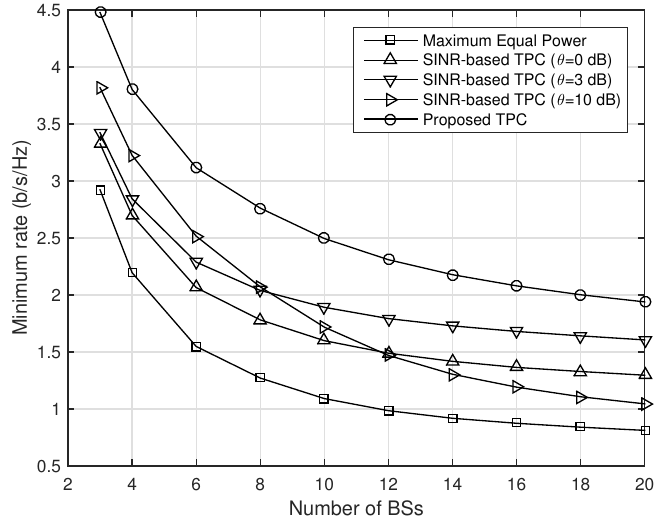
Figure 6. Minimum rate vs. number of